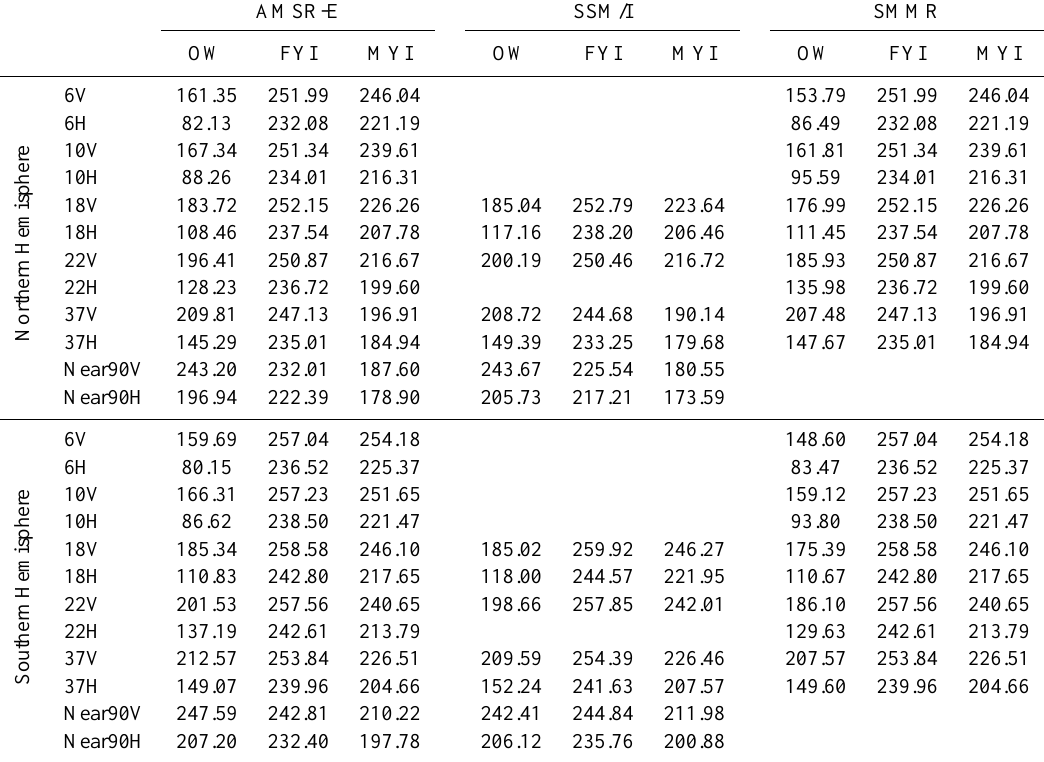
Table A1. The RRDP tie points: brightness temperatures in